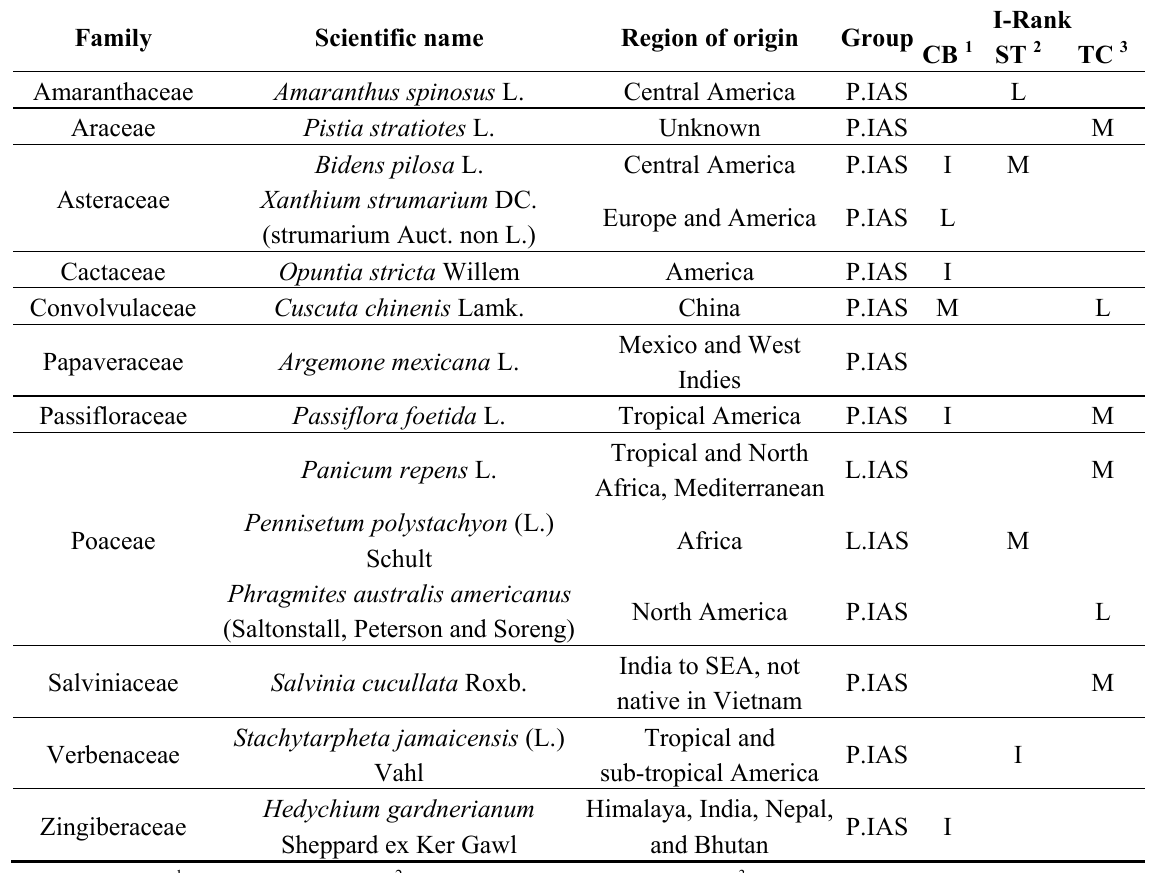
Table 3. The risk (I-Rank) of likely and potential alien plant species at three parks. The risks were categorized as in Table